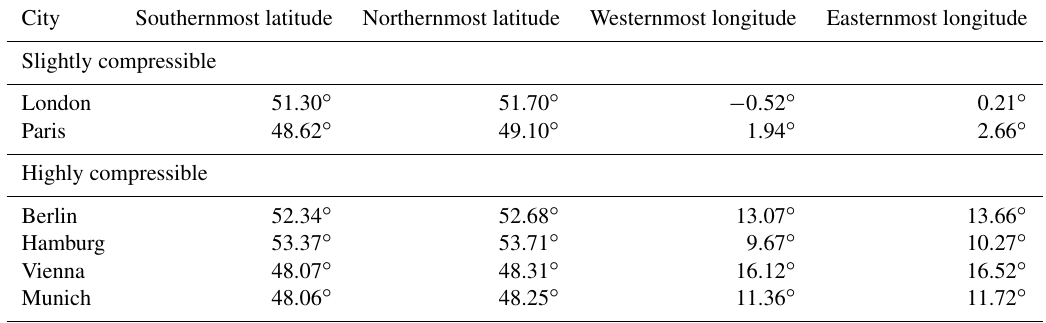
Table A1. Longitude and latitude boundaries used to create the CO 2 emission inventories for the European cities from the TNO_GHGco_v1.1 emission